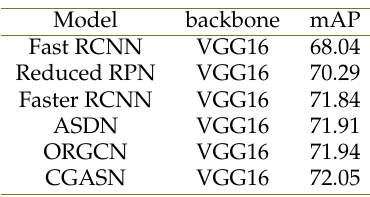
Table 5. Comparison of experimental